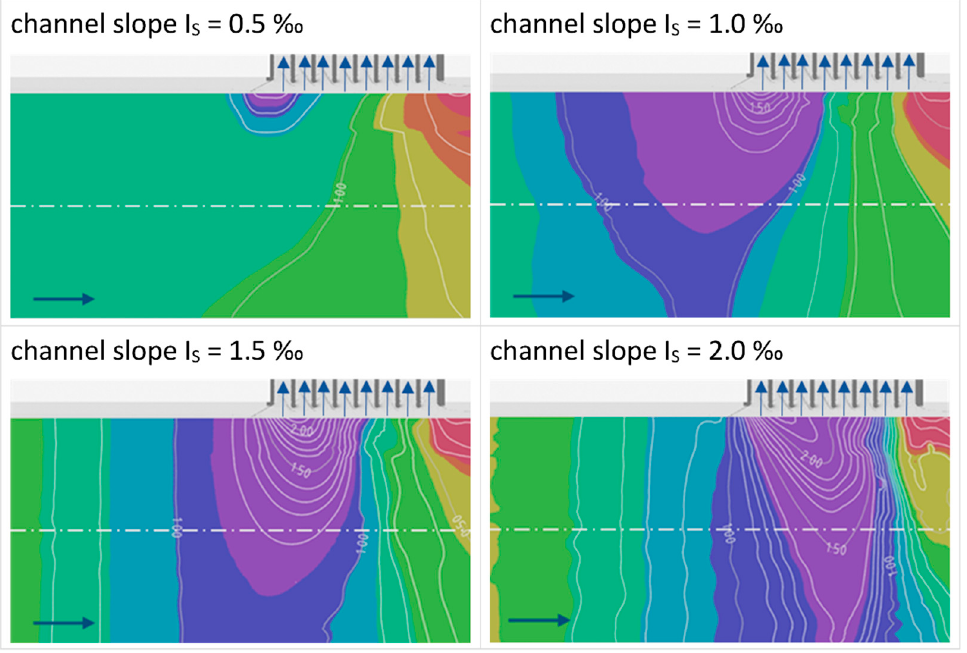
Figure 2. Spatially distributed drawdown of the water surface in the channels (m) due to water diversion through the side weir with eight open weir fields (blue arrows); channel slope I S ranges between 0.5 and 2.0‰; the illustrated contour lines reflect the reduction of flow depth in meters compared to the undisturbed normal flow depth; the dash-dot line represents the main channel axis; the main flow direction is from left to right.